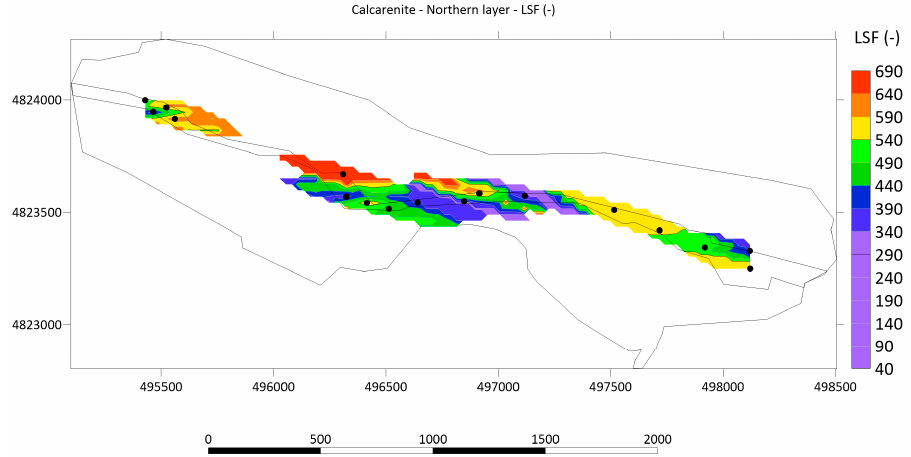
Figure 13. Map of SiO 2 (%) in unit (5), northern layer (boreholes are black dots).